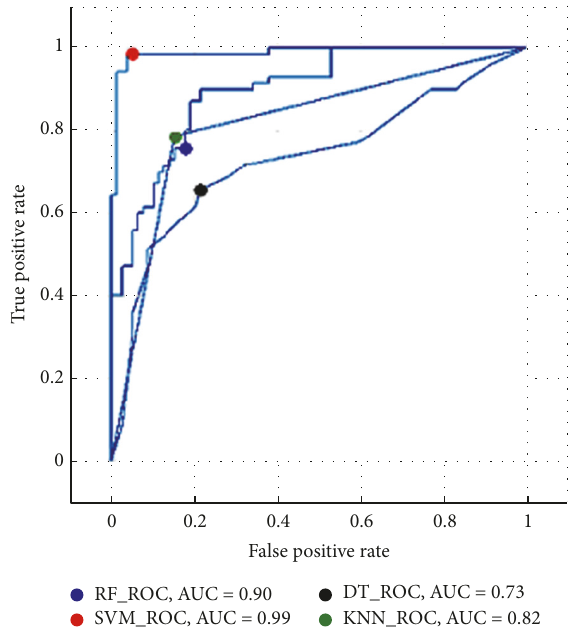
Figure 3: ROC comparison (ignition system). Table 1: Ignition system VMMS.